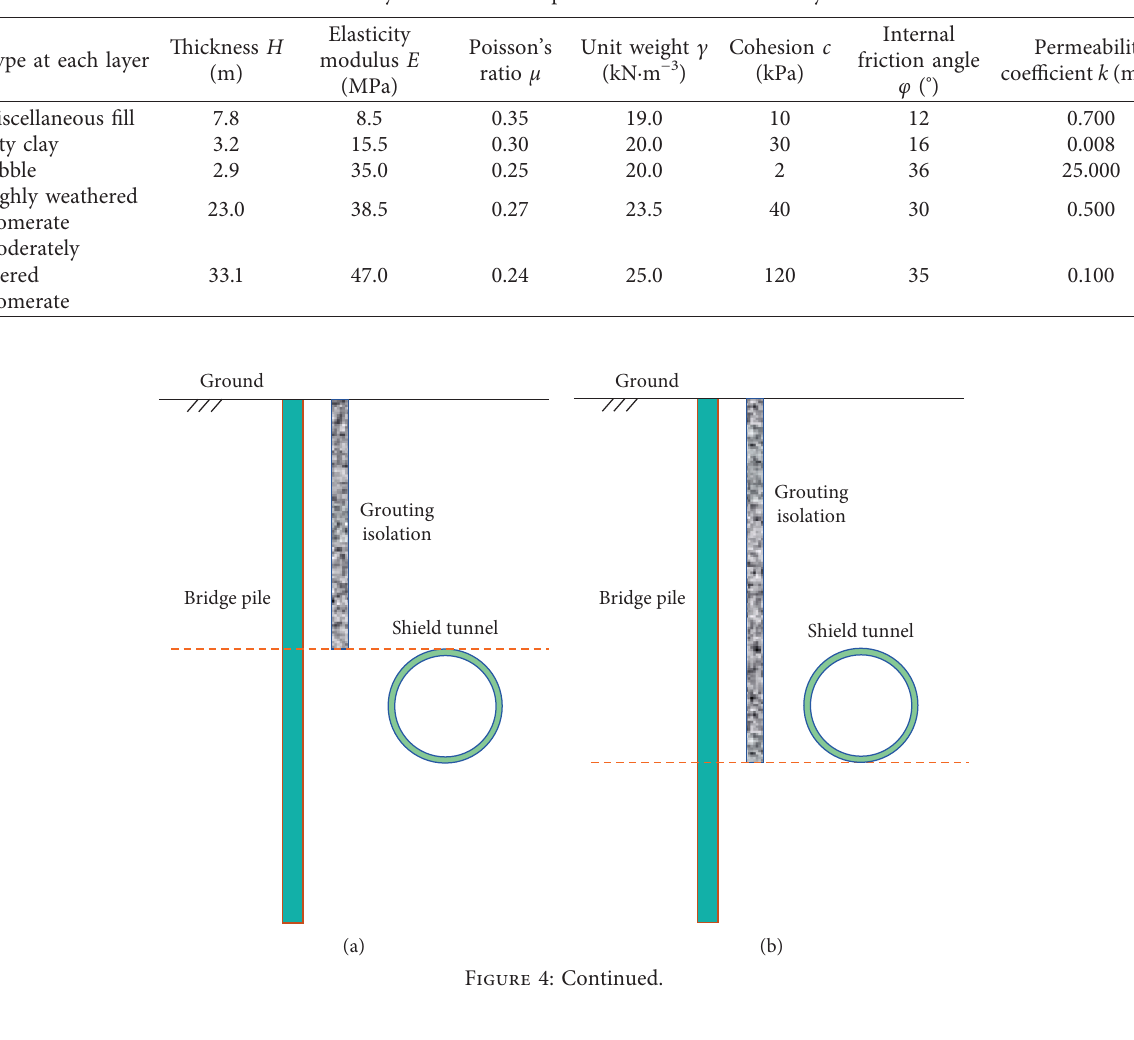
Figure 3: Engineering geology profile. Table 1: Physical mechanical parameters of surrounded layers.